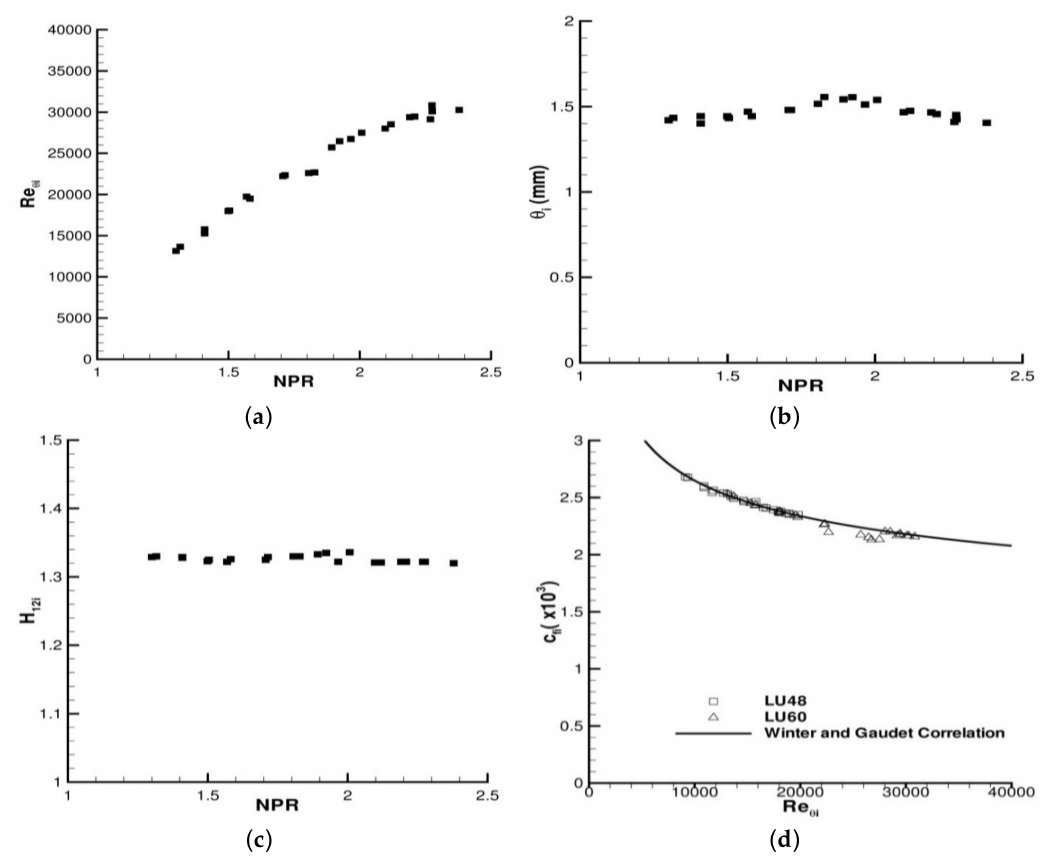
Figure 6. Nozzle inlet boundary layer parameters: ( a ) Momentum thickness Reynolds number; ( b ) Momentum thickness; ( c ) Shape factor; ( d ) Skin friction coefficient.